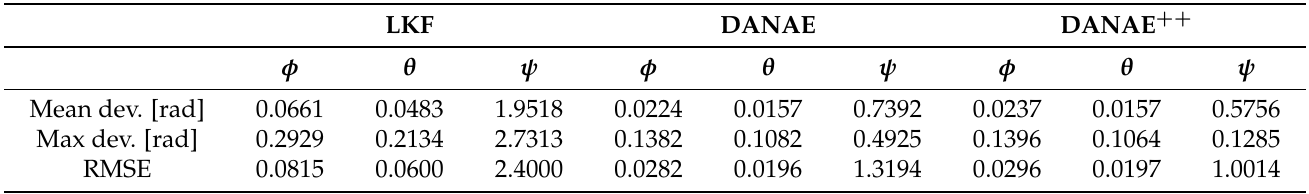
Figure 3. OxIO Dataset: roll angle estimation provided by the LKF (top, light brown) and DANAE (bottom, light blue) compared to the GT (dark red). This experiment was performed on a subsection of the slow walking set. Table 2. OxIO Dataset: evaluation of the performances of the LKF, DANAE and DANAE ++ w.r.t. the GT for the three Euler